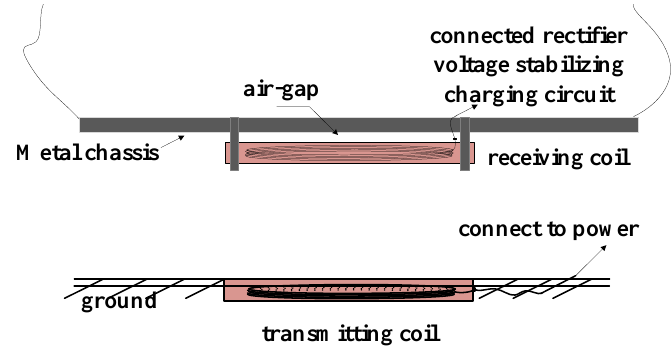
Figure 1. The interaction between EVs wireless charging system and metal plate.